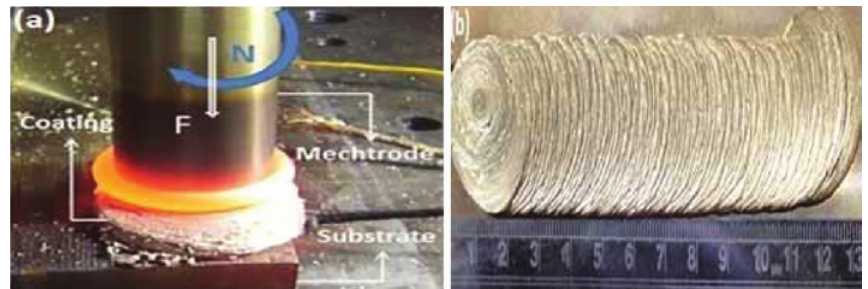
Figure 1: Friction surfaced sample. (A) Deposition stage, (B)